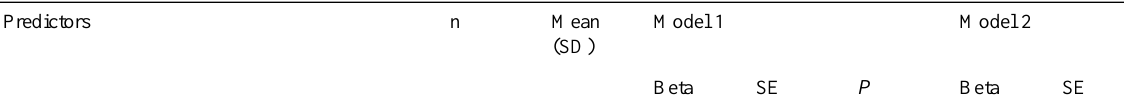
Table 6. Predictors of time on-site reporting only with P <.10.